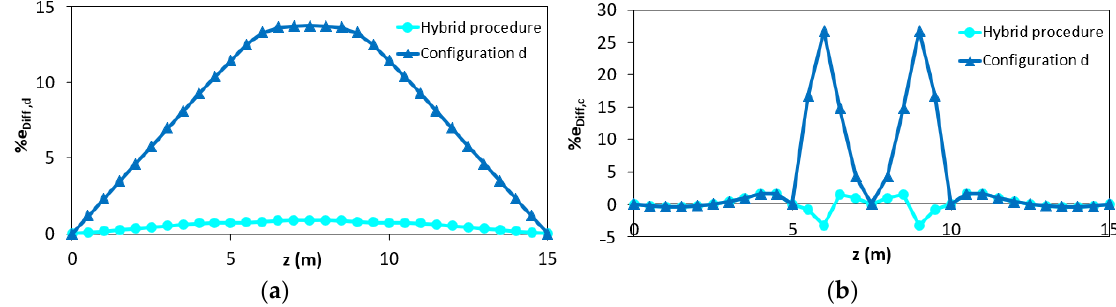
Figure 15. Distribution of the percentage difference in case of the hybrid procedure (blue curves) and without hybrid